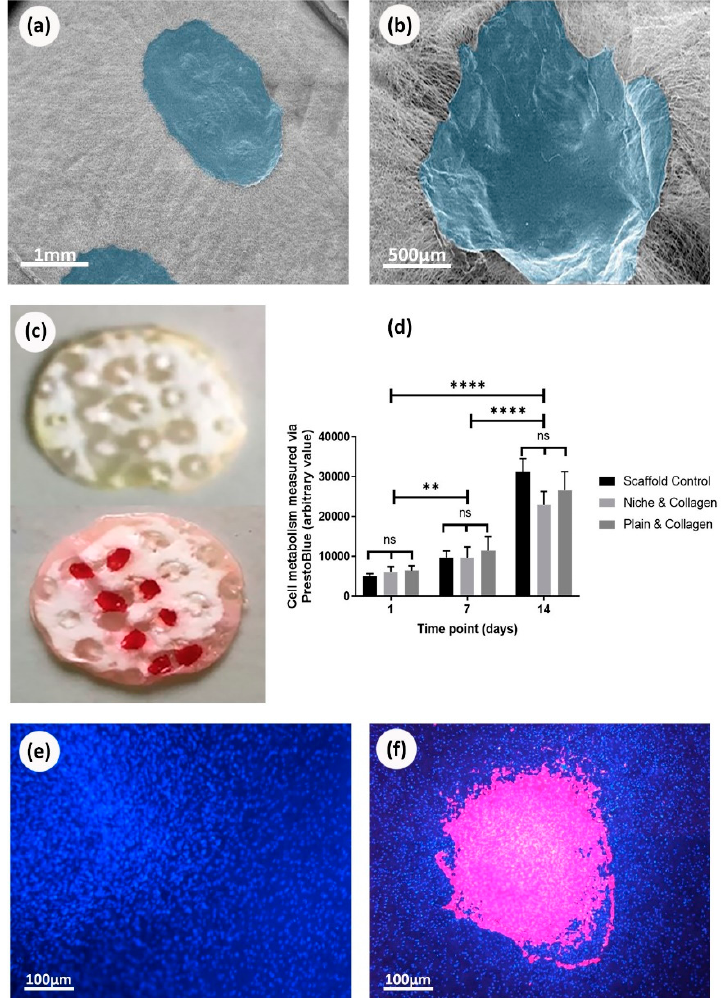
Figure 6. Deposition of collagen onto electrospun scaffolds and 14th day culture with MSCs: ( a ) SEM image of plain scaffolds with collagen deposited on the surface. Collagen false colored blue using photoshop; ( b ) SEM image of collagen deposited into niches on electrospun scaffolds. Collagen false colored blue; ( c ) Sirius red staining of scaffold control and red staining of scaffolds with collagen deposition showing the presence of collagen; ( d ) cell metabolic data from PrestoBlue ® assay based on a 14 day culture of rMSC cells on electrospun scaffolds with and without niches and collagen. No statistical difference is found between any of the conditions, ANOVA; ( e ) fluorescence image of nuclei DAPI staining (blue) 14 days culture of rMSC cells on plain scaffolds without collagen; ( f ) fluorescence image of nuclei DAPI staining (blue) from 14 days culture of rMSC cells on plain scaffolds with collagen (false colored pink).